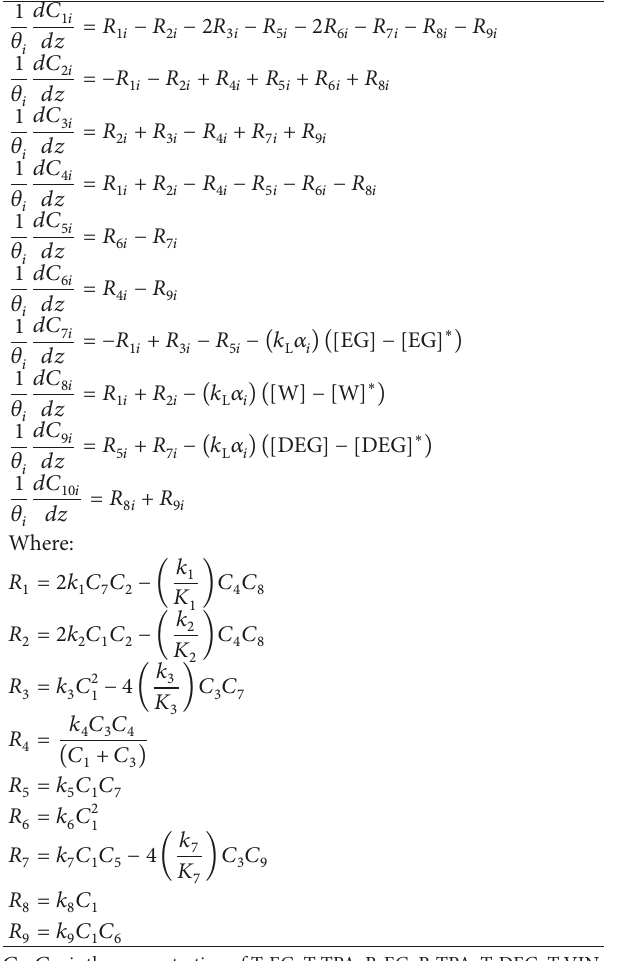
Table 3: Model equations used in this study [28, 36].